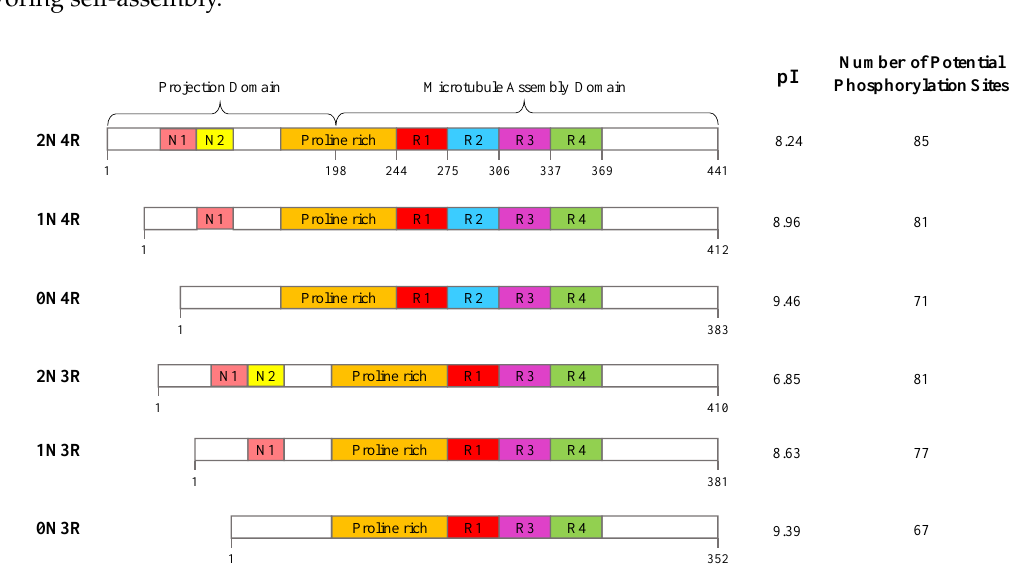
Figure 6. Tau isoforms in the human brain. Tau consists of a projection domain and a microtubule-assembly domain. The six tau isoforms (2N4R, 1N4R, 0N4R, 2N3R, 1N3R, AND 0N3R) are designated by the number of N inserts in the former and by the number of repeats R in the latter. Calculated pI’s indicate that the isoforms except 2N3R are basic proteins. The number of potential phosphorylation sites in each isoform is indicated.